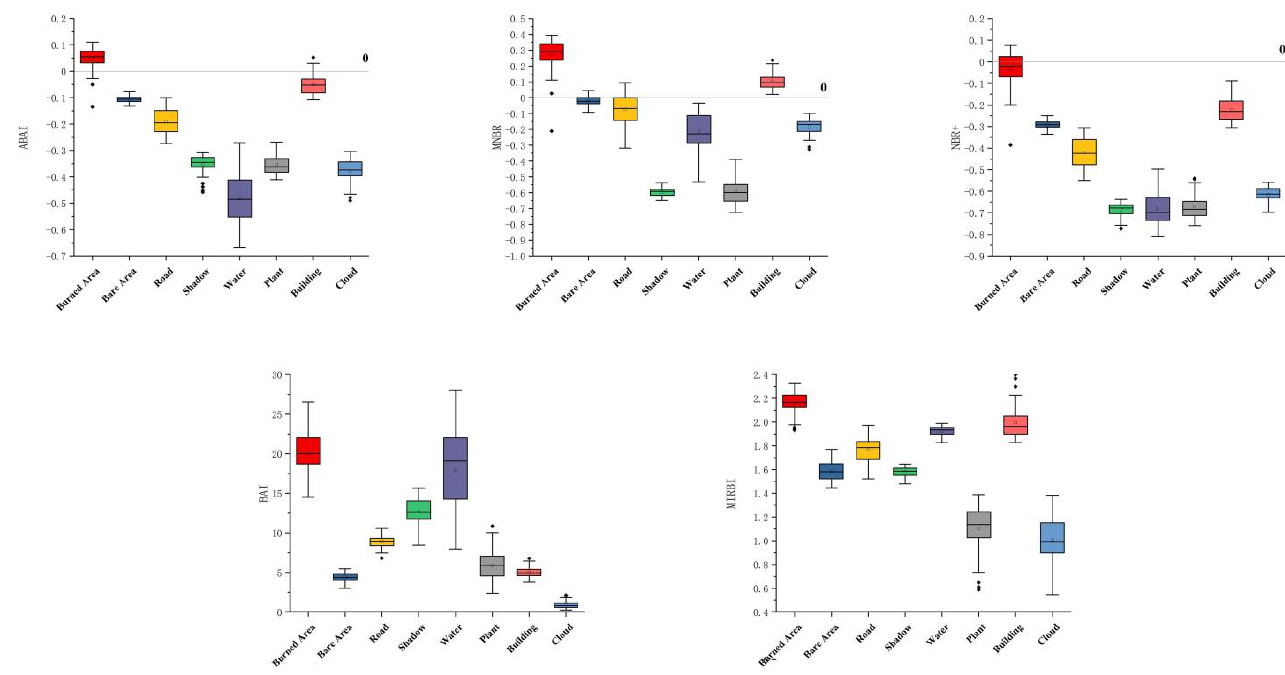
Figure 4. Stability comparisons between the proposed ABAI and typical burned area indices.